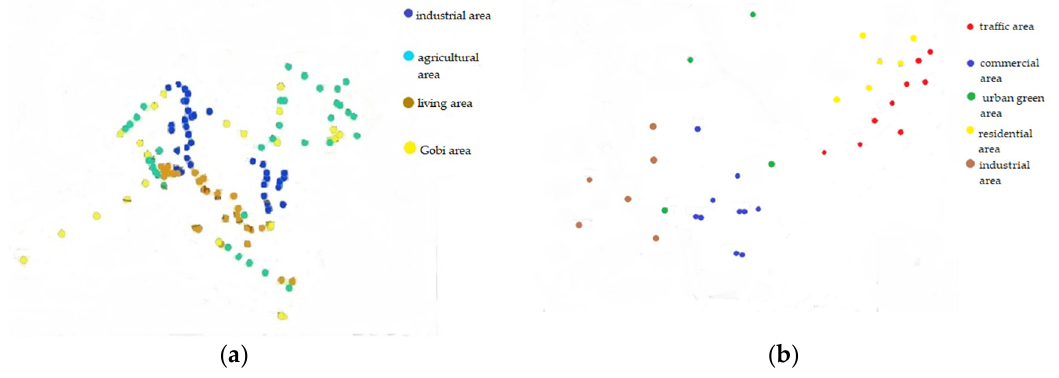
Figure 15. ( a ) Real dataset 1; ( b ) Real dataset 2.